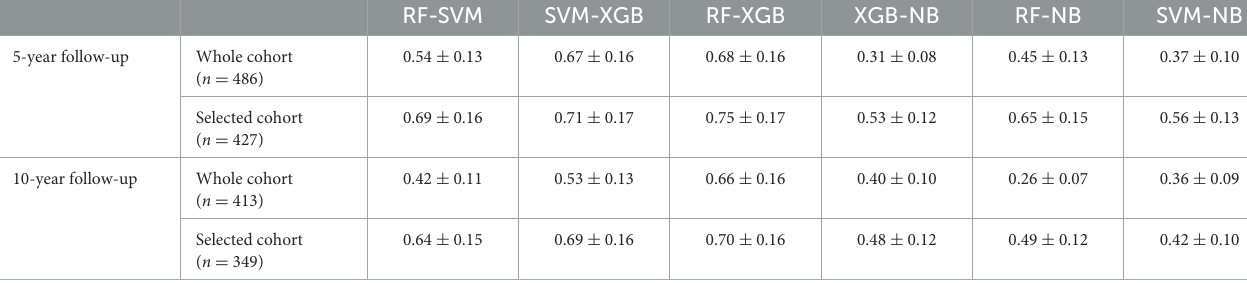
TABLE 1 Cohen’s kappa ( κ ) coefficient computed for pairs of classifiers before and after the application of the iterative consensus procedure.